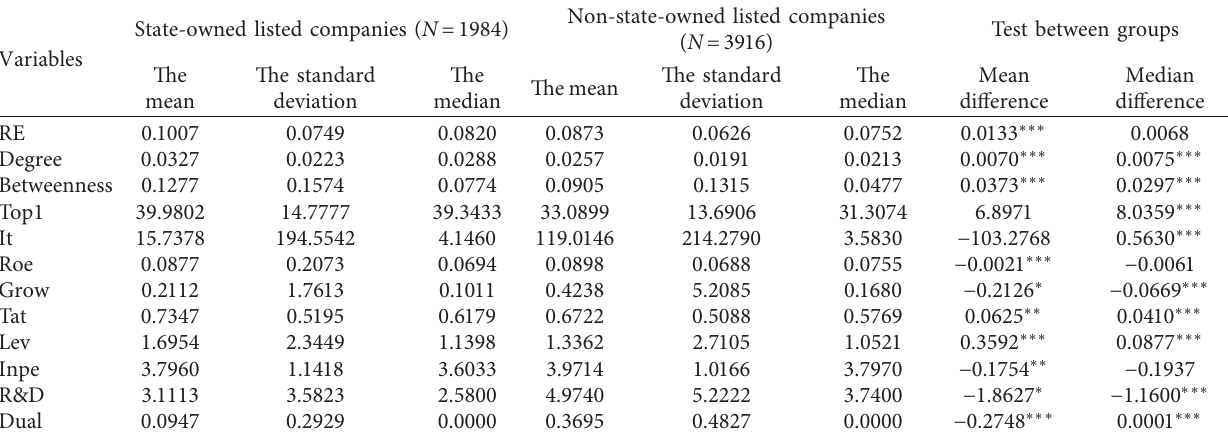
Table 2: Variables in the subsample classified by property right